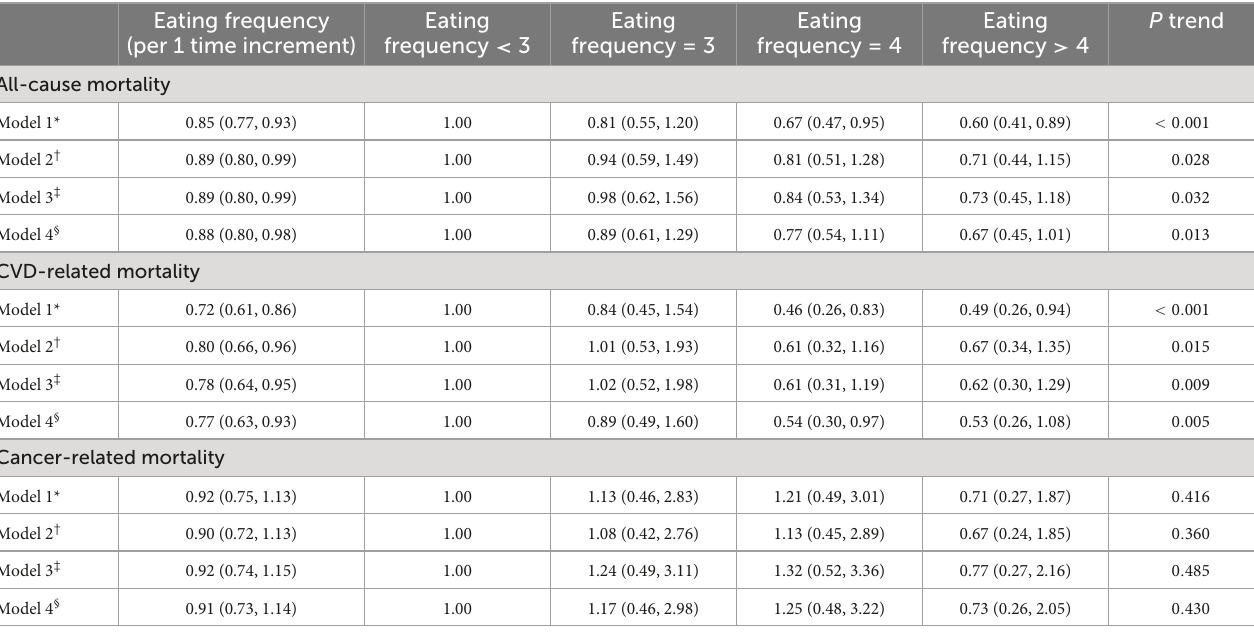
Eating frequency < 3